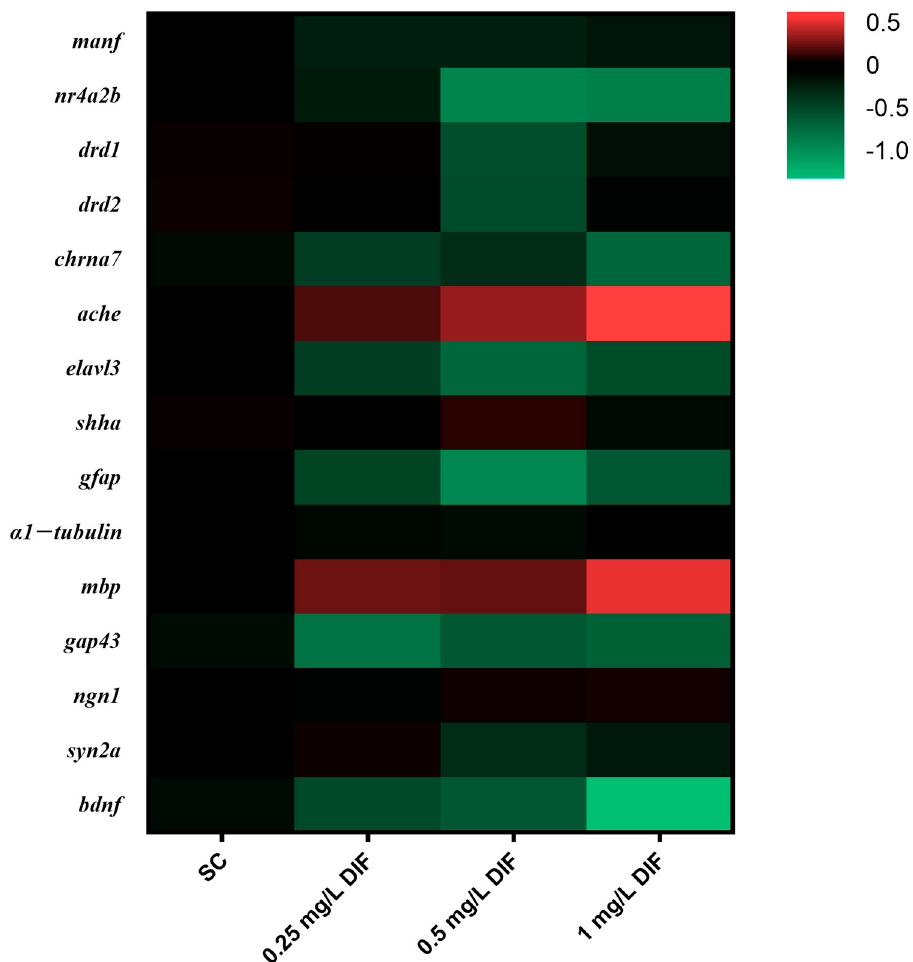
Figure 6. Heat map of gene transcription alterations measured by qPCR after exposure to difeno- conazole (0, 0.25, 0.5, and 1 mg/L) at 120 h (mean ± SEM, n = 3). The data are expressed as means of 3 replicate samples (30 larvae/replicate) after logarithmic conversion based 2 in the heat map. The red (data > 0) indicates upregulation of gene expression, while the green (data < 0) indicates downregulation of gene expression.